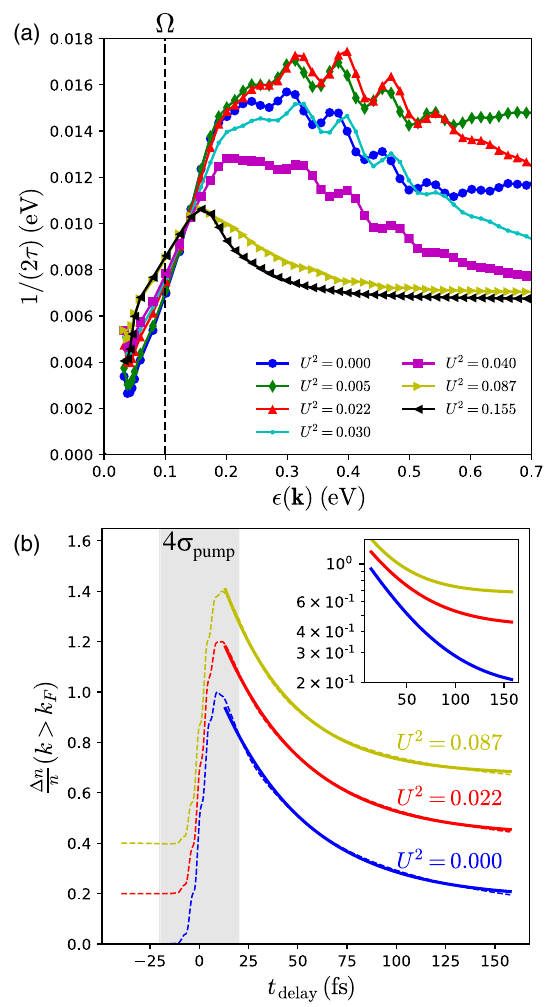
FIG. 8. (a) Population decay rates after excitation showing a nonmonotonic dependence on the Coulomb-scattering strength U (values of U 2 are in eV 2 ). Outside the phonon window, after an initial increase, the decay rates decrease. Some of the data are reproduced from Ref. [28]. (b) Quasiparticle weight above the Fermi level for phonon and Coulomb scattering (offset for clarity). The solid lines are single exponential fits to the region where the solid line is shown, which should not work if time- scales separate. The shaded region indicates (cid:3) 2 σ of the pump field. Inset: Semilogarithmic plot of the same